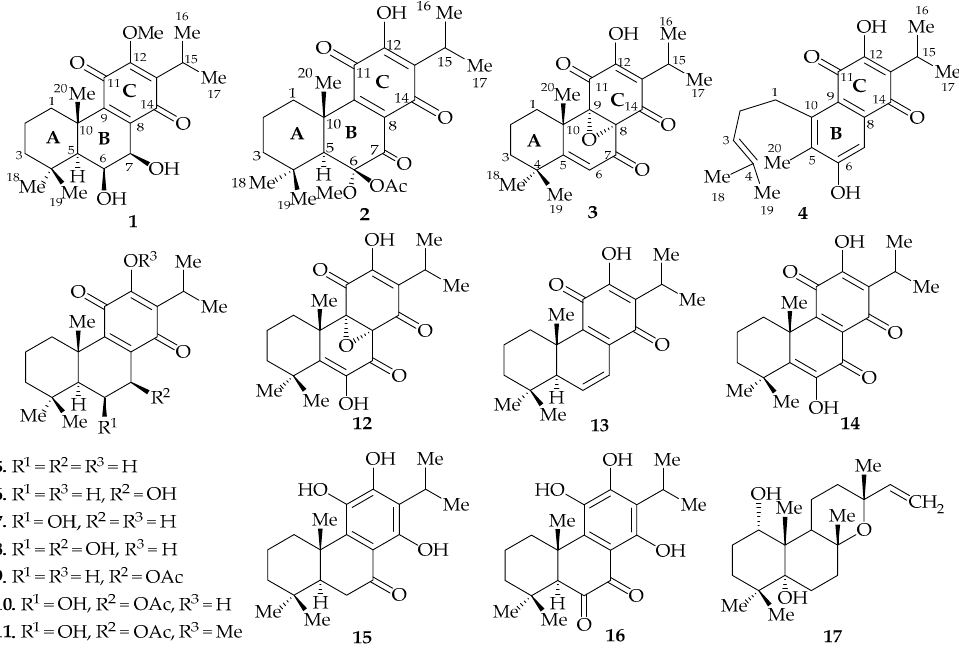
Figure 1. Structures of the isolated compounds.